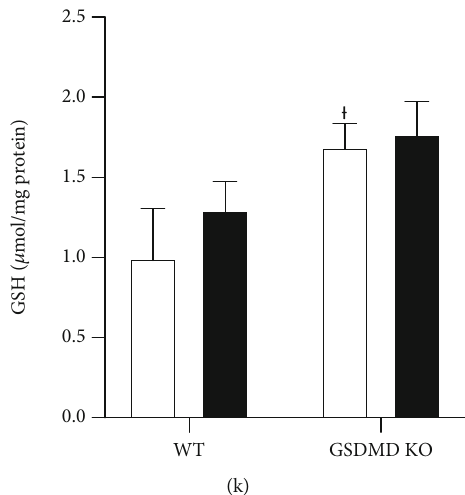
Figure 4: Adipose tissue in fl ammation and metabolism in wild-type (WT) and gasdermin D knockout (GSDMD KO) mice fed a high-fat diet (HFD). (a, c, d, g, h, and i) Real-time PCR analysis of genes in visceral adipose tissue (VAT). The expression level of each target was normalized using 18S rRNA. (b) IL-1 β protein expression in VAT was measured by ELISA assay. (e, f, and j) Representative western blots and quantitative analysis of protein expression in VAT. The protein expression level was normalized using β -actin. (k) GSH concentration in VAT was evaluated by GSH Detection Assay kit. ∗ p < 0 : 05 vs. same genotype mice fed a NCD, † p < 0 : 05 vs. WT NCD group, and # p < 0 : 05 vs. WT HFD